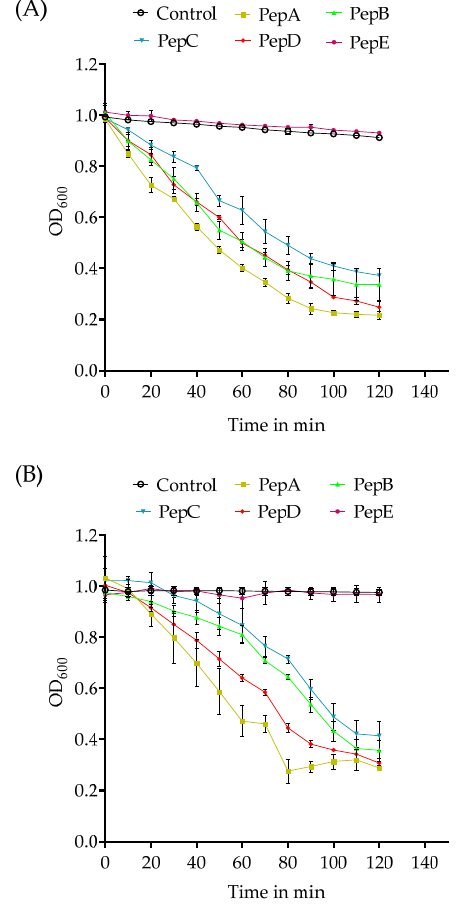
Figure 1. Turbidometric agglutination of S. aureus (panel ( A )) and S. pneumoniae (panel ( B )) after incubation for 2 h at 37 °C with different peptides (0.1 µmol peptide/mL). PBS served as the control. The results shown represent the mean values with standard deviations of three independent exper- iments. As exemplarily presented in Figure 2 for S. aureus , several peptides were capable of binding to bacteria and causing agglutination. The agglutination was visible with the bare eye. In the PBS control and with the peptide PepE, no agglutination occurred.